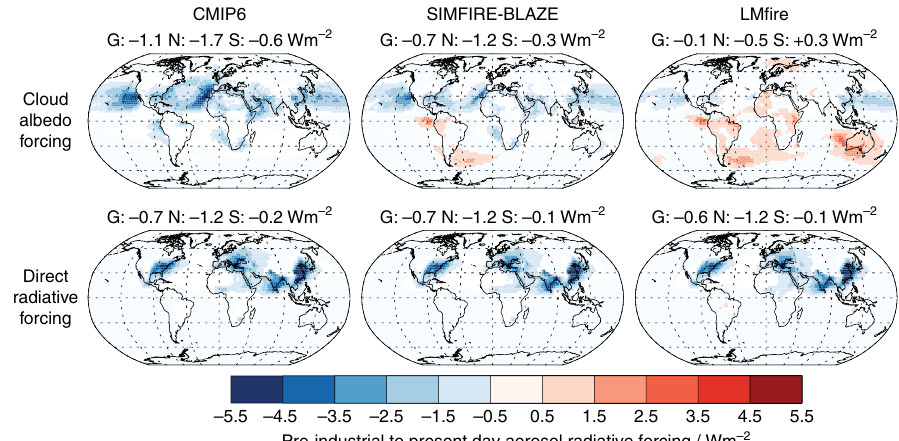
Fig. 4 Annual mean pre-industrial to present-day aerosol cloud albedo forcing and direct radiative forcing. Annual mean radiative forcing values are given above each map for Global (G), Northern Hemisphere (N) and Southern Hemisphere (S) regions